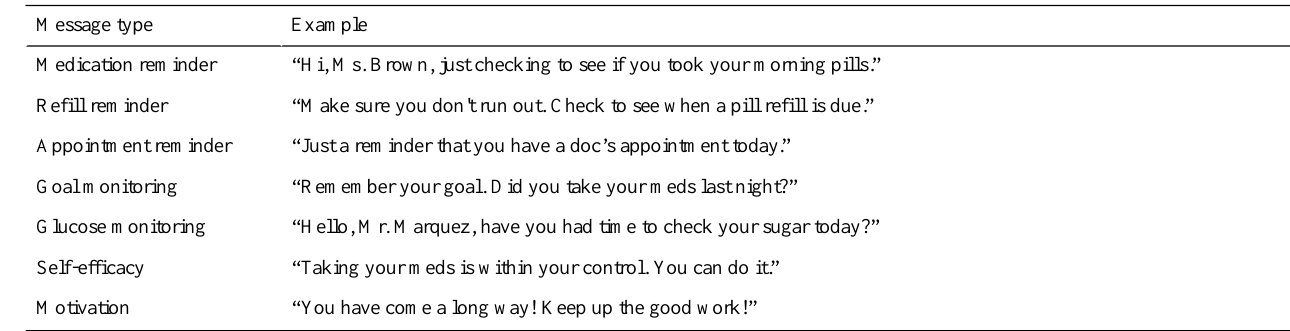
Table 1. Example text message